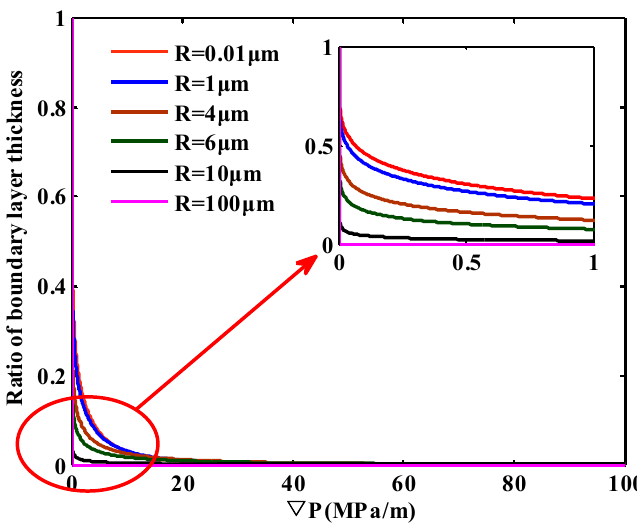
∇ P under different radial micro